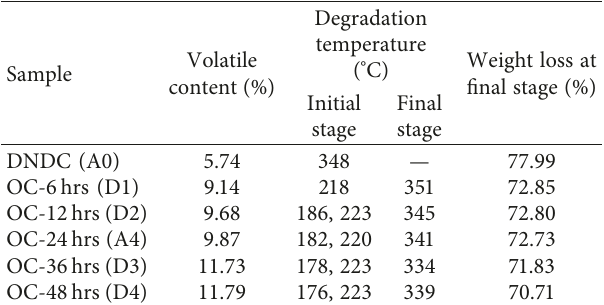
Figure 12: (a) TGA and (b) DGTA curves of DNDC (A0) and the OC products. Table 3: Thermal gravimetric data of DNDC (A0) and the OC